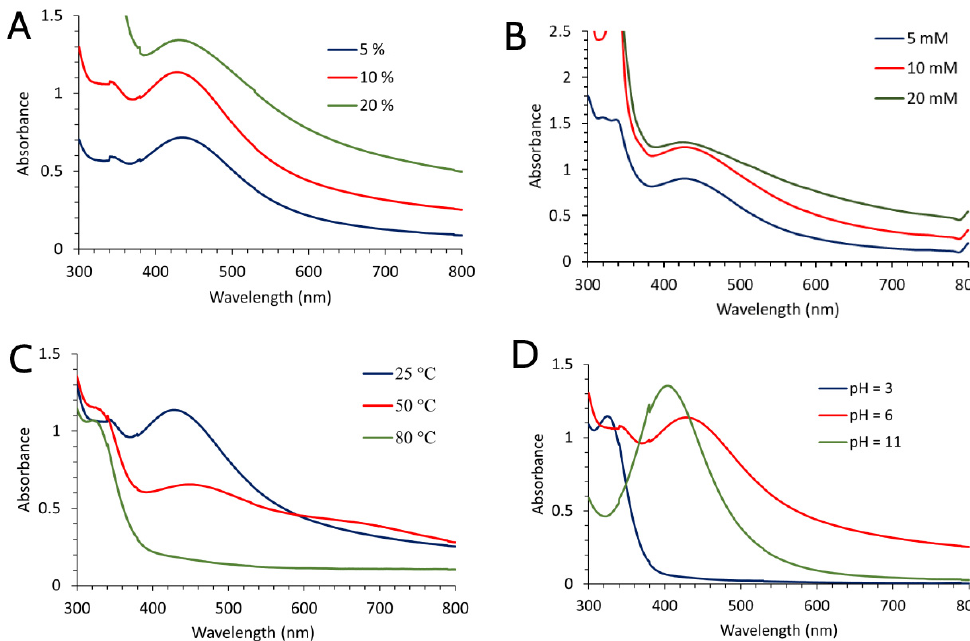
Figure 1. UV-Vis absorption spectra of AgNPs synthesized using S. verticillata aqueous extract de- pending on the application of different synthesis conditions (extract concentration ( A ), concentration of AgNO 3 ( B ), temperature ( C ), and pH of extract solution ( D )).